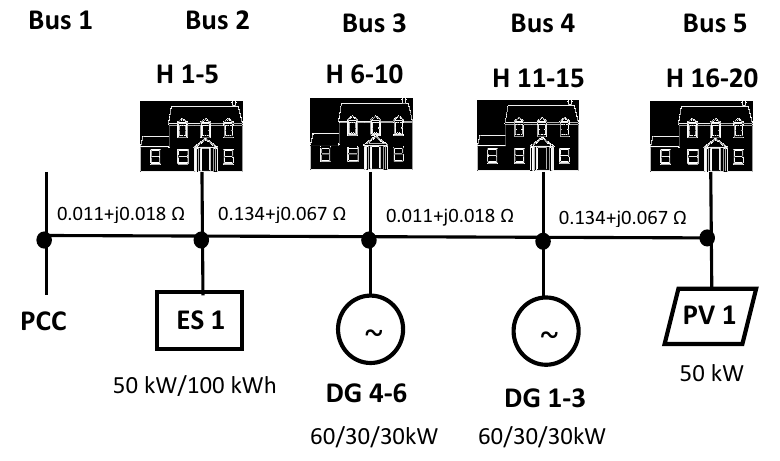
Figure 3. Community microgrid test